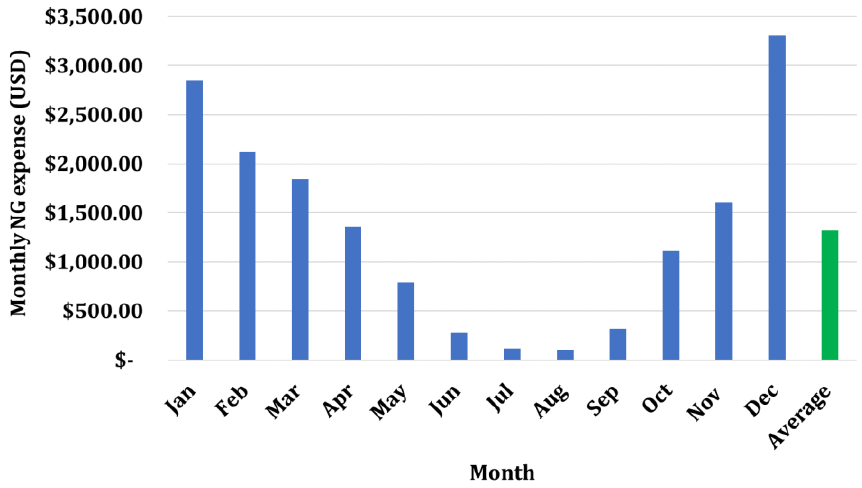
Figure 29. Monthly natural gas expense in Ontario to heat Greenhouse 2.